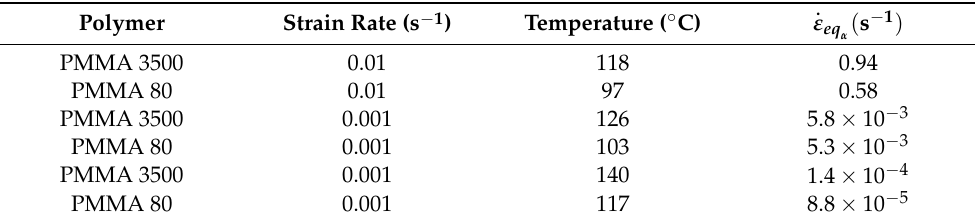
Figure 4. Comparison between tension and shearing for PMMA 80 at an equivalent strain rate of 10 − 2 s − 1 at 130 °C. Stress ( σ ) vs. strain ( ε ) curves for two equivalent experimental sets of conditions are given in the legend. Squares represent shearing ( 𝜎 (cid:3051)(cid:3052) 𝑣𝑠. 𝜀 (cid:3051)(cid:3052) ); circles represent tension ( 𝜎 (cid:3051)(cid:3051) 𝑣𝑠.𝜀 (cid:3051)(cid:3051) ). In addition, it can be seen in Figure 5 that the differences could be up to 15% (although they appeared small on log-scales) depending on the material and on the temperature, which was only 5 degrees apart from the reference temperature. This of course could have had an impact on modeling based on the notion of the equivalent strain rate as a parameter